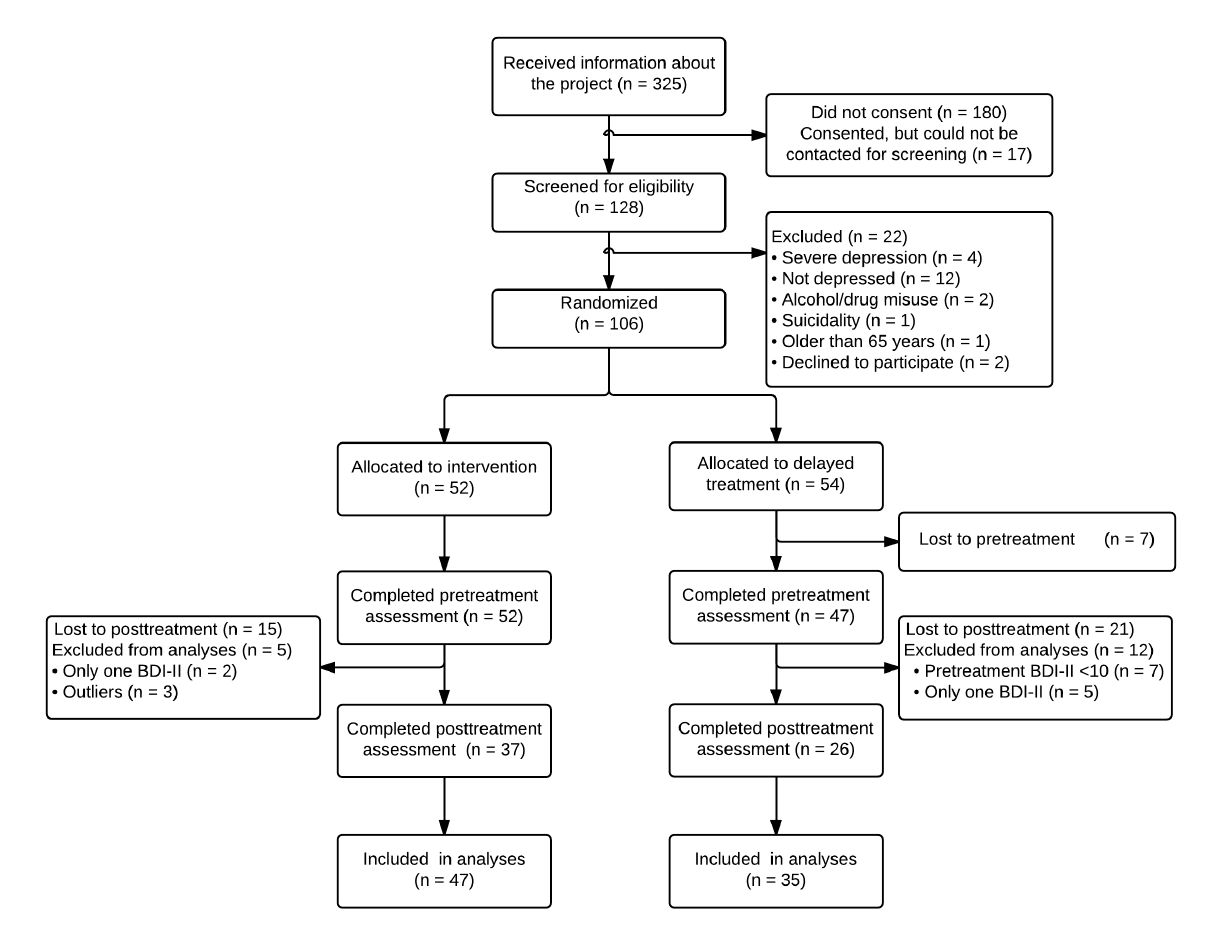
Figure 1. Flow of participants through the